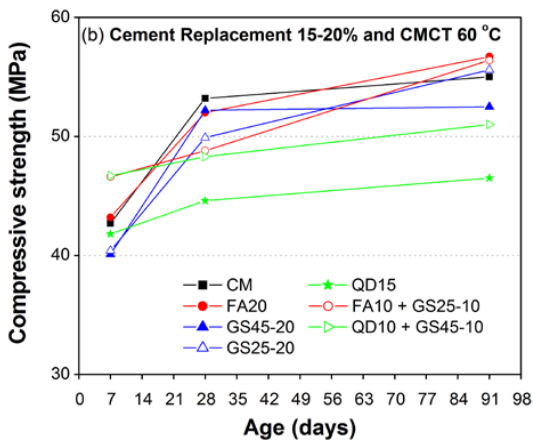
Figure 8. Effect of high curing temperature (60 °C) on compressive strength development of CM and mortar containing GS, QD and FA as a partial replacement of cement: ( a ) 10%; ( b ) 15%–20%.